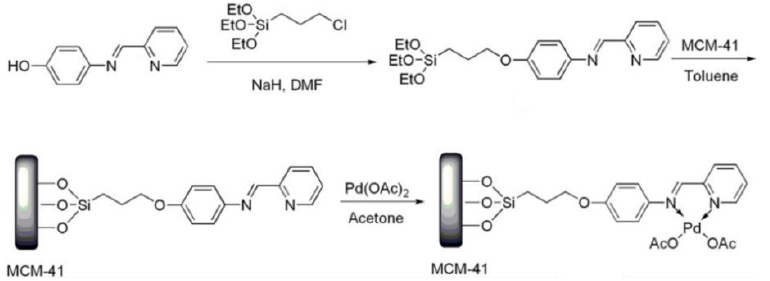
Figure 19. Schematic representation of the preparation of MCM-41 supported Pd complex [111]. Reprinted with permission from [111]. Copyright 2013, Elsevier.